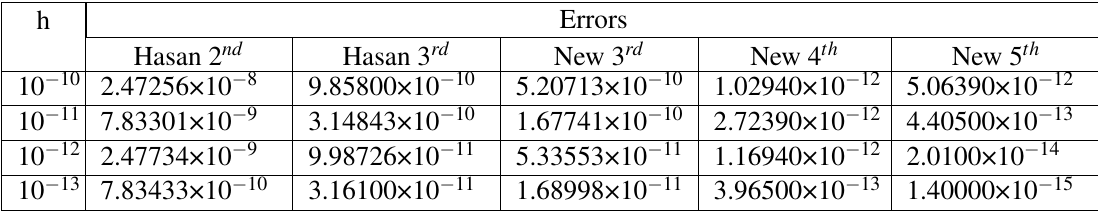
Table 4.2 (c): Absolute errors of the solution of Eq. (22) at x=0.0000000001 by Hasan’s [13, 16] methods and new methods with Romberg